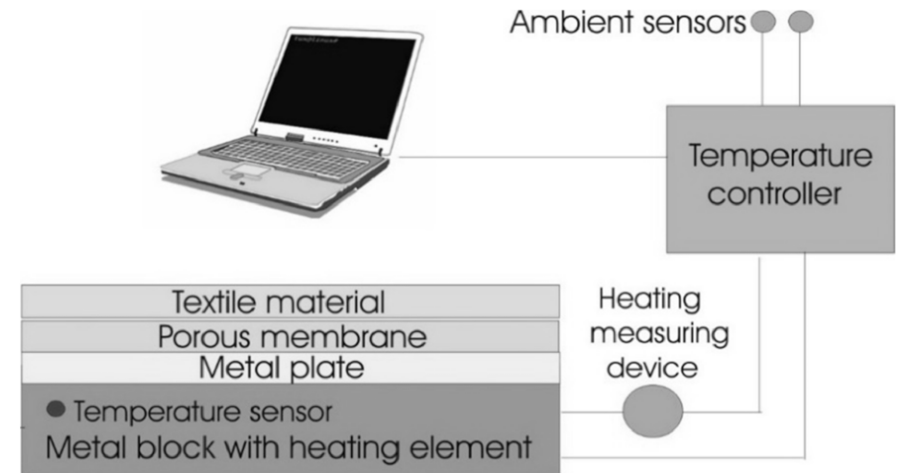
Figure 4. Principle of sweating guarded hotplate (SGHP) device.